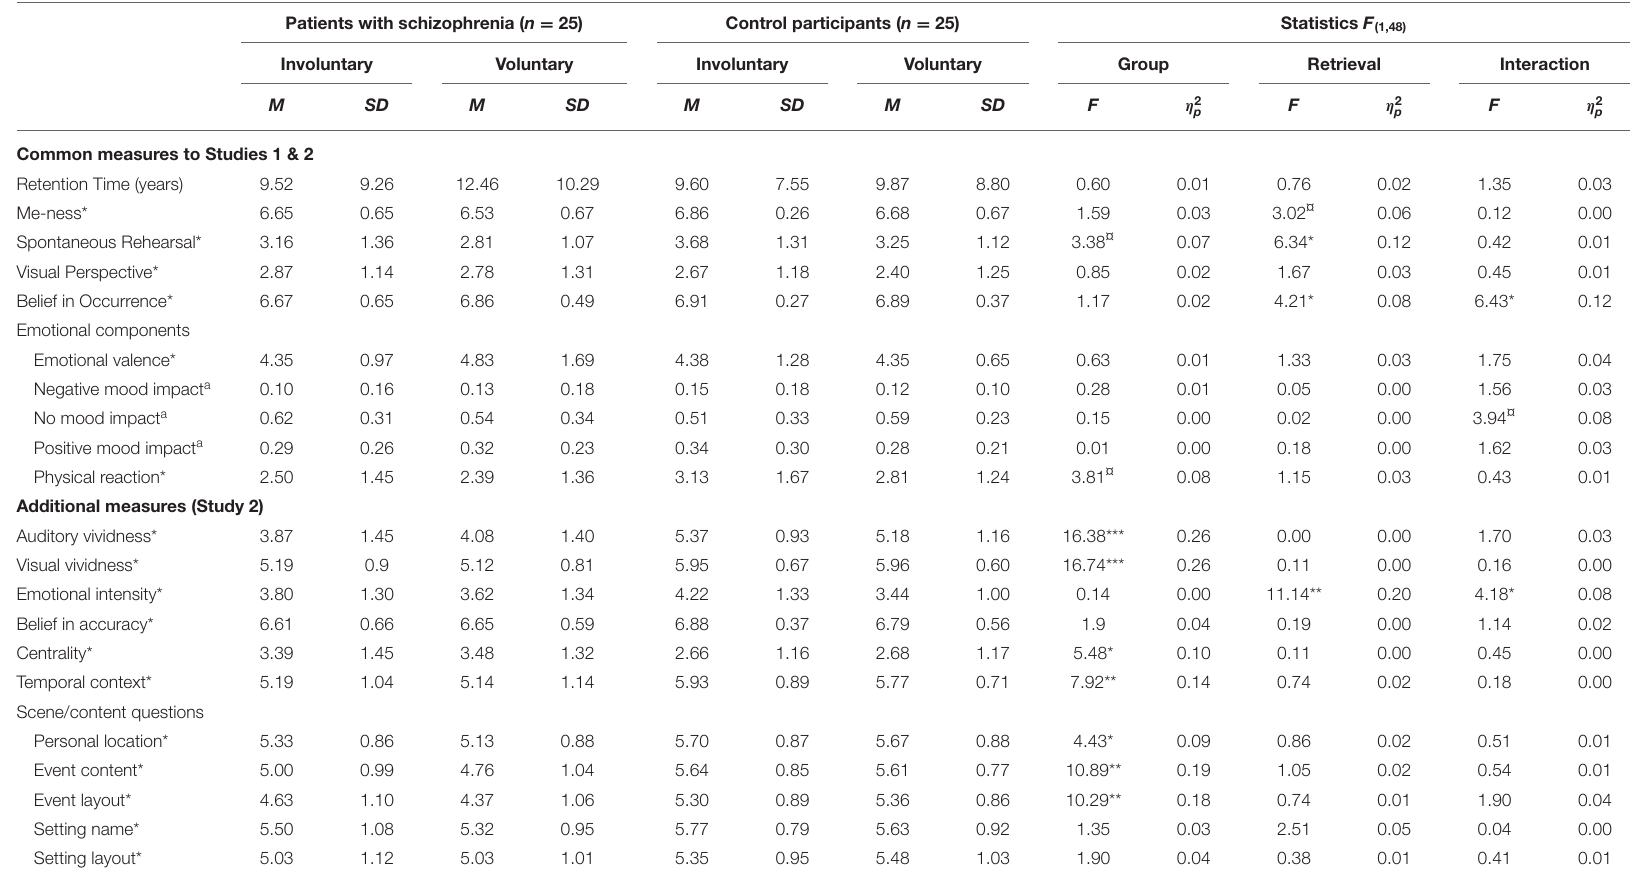
TABLE 5 | The characteristics of involuntary and voluntary autobiographical memories in patients with schizophrenia and control participants in Study 2. Patients with schizophrenia ( n = 25) Control participants ( n = 25) Statistics F (1,48) Involuntary Voluntary Involuntary Voluntary Group Retrieval Interaction